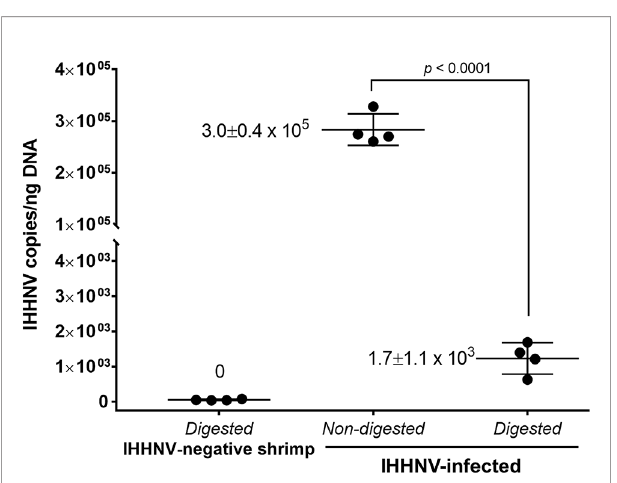
FIGURE 4 | Detection of IHHNV by the digital droplet PCR method in non- digested and digested total DNA prepared from IHHNV-negative and IHHNV- infected shrimp ( P. monodon ).